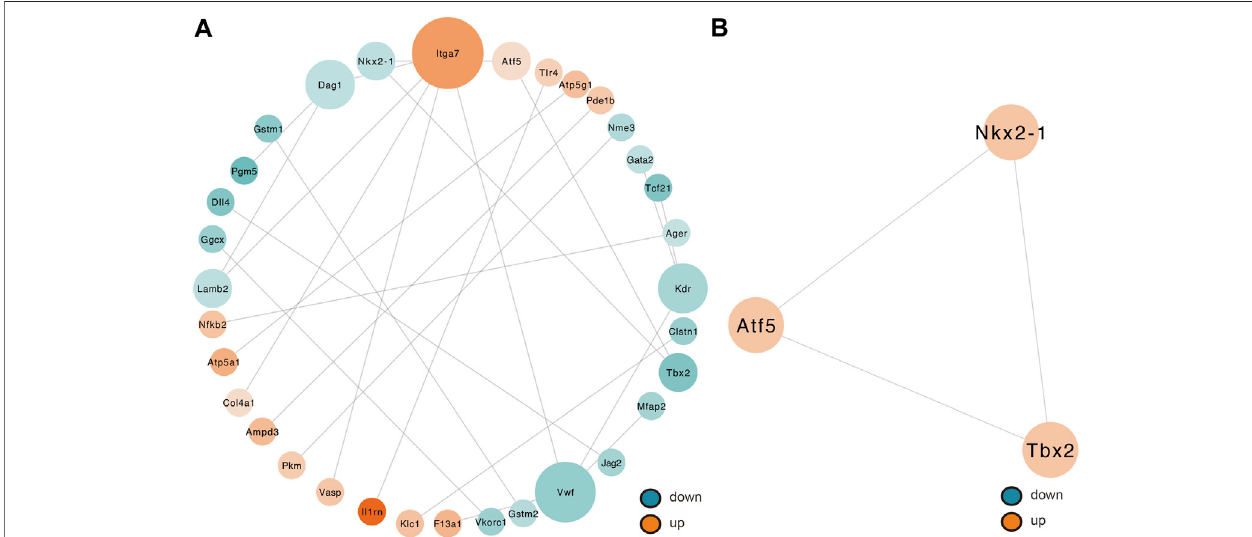
FIGURE7| DeterminationofhubgenesfromthePPInetworkbytheMCODEalgorithm. (A) PPInetworksof209targetgenesthatplayanindispensableroleinALI. This network makes up 33 nodes and 24 edges. The node color shifts from green to red gradually in ascending order, basing on the log2 (fold change) of genes. The node size shifts from small to large gradually in ascending order, basing on neighbored gene numbers per gene. (B) PPI network with the three hub genes isolated from (A) . This network makes up of three nodes and three edges. PPI, protein – protein interaction; MCODE, Molecular Complex Detection.